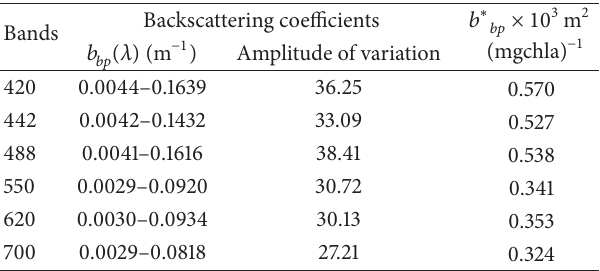
Table 1: Summary of A . anophagefferens backscattering characteris- tics.